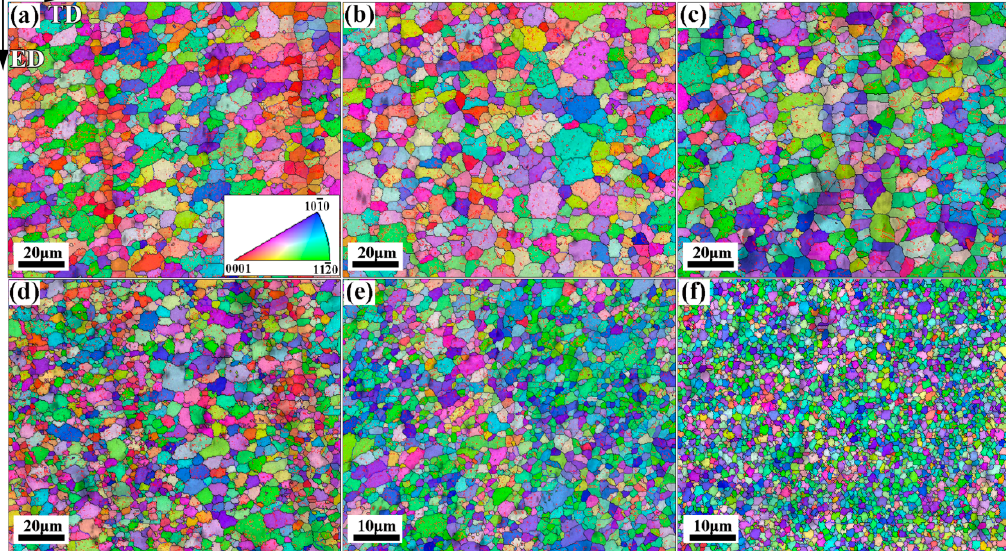
Figure 4. Microstructure of CECed ZK61 alloys rods at different passes and temperature: ( a ) 350 ◦ C 2P; ( b ) 350 ◦ C 4P; ( c ) 350 ◦ C 16P; ( d ) 300 ◦ C 2P; ( e ) 250 ◦ C 2P; and, ( f ) 200 ◦ C 2P.